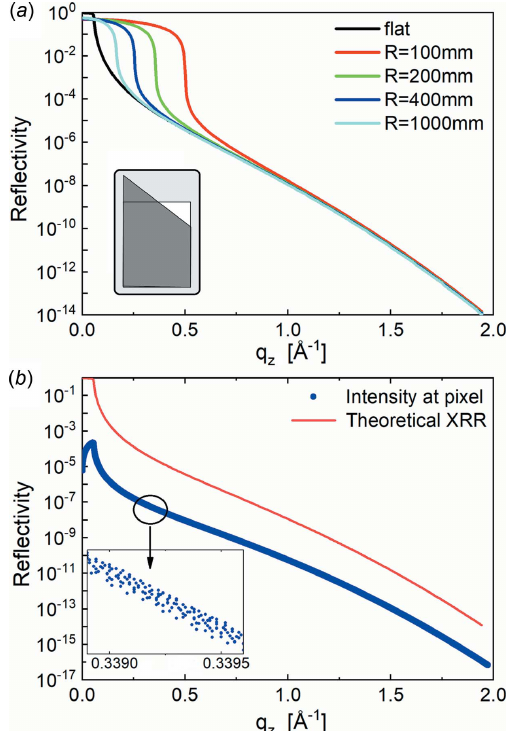
Figure 5 ( a ) Approximated reconstruction of the reflectivity curve (green line) using the 2D map of Fig. 4( c ) and the detector integration approach (integration along horizontal lines) for the case of a curvature radius R = 200 mm and a beam size 2 W V = 50 m m. The black curve corresponds to the theoretical XRR on the flat surface ( R = 1 ). The effect of W V / R on the reconstructed reflectivity curve calculated at W V = 25 m m for a series of surface curvatures with radius R is demonstrated with the colored curves. The interval, where colored curves coincide with the curve calculated for the flat surface (black curve), corresponds to the interval, (cid:5) i > 2 (cid:5) i,m , where the effect of the curvature can be neglected. Inset: geometrical illustration of the equivalence of the integrated reflectivity intensity on the flat and curved surfaces at the effective grazing angle above 2 (cid:5) i,m . The rectangle represents the integrated reflected intensity on the flat surface at the effective grazing angle (cid:5) i . The right-angled trapezoid represents the integrated reflected intensity on the curved surface also at (cid:5) i . ( b ) Reflectivity intensity at each pixel (blue dots) of the 2D map in Fig. 4( c ). The red curve is a theoretical XRR curve on a flat surface. Insert: zoom of a small part of the graph with measured intensity at q z around 0.3393 A˚ (cid:3) 1 ; at this magnification, the blue curve consists of